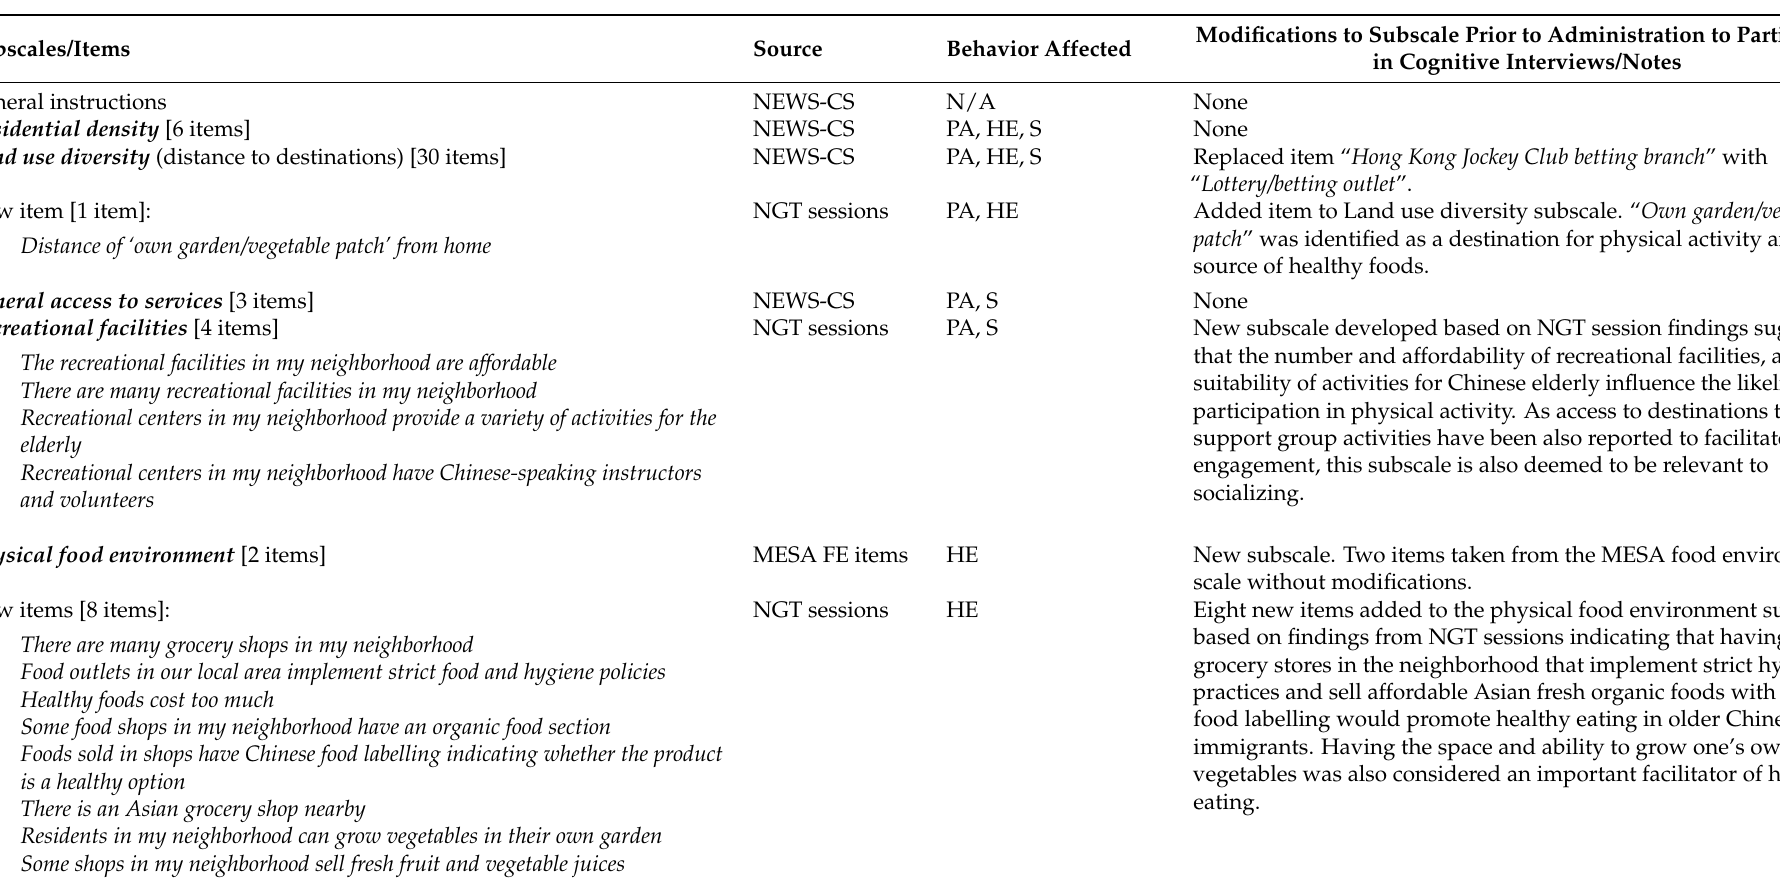
Table 2. Initial questionnaire items of perceived neighborhood attributes associated with physical activity, healthy eating, and socializing appropriate for older Chinese immigrants to Australia: content, sources of items, and modifications prior to administration to participants (Neighborhood Environment for Healthy Aging–Chinese Immigrants to